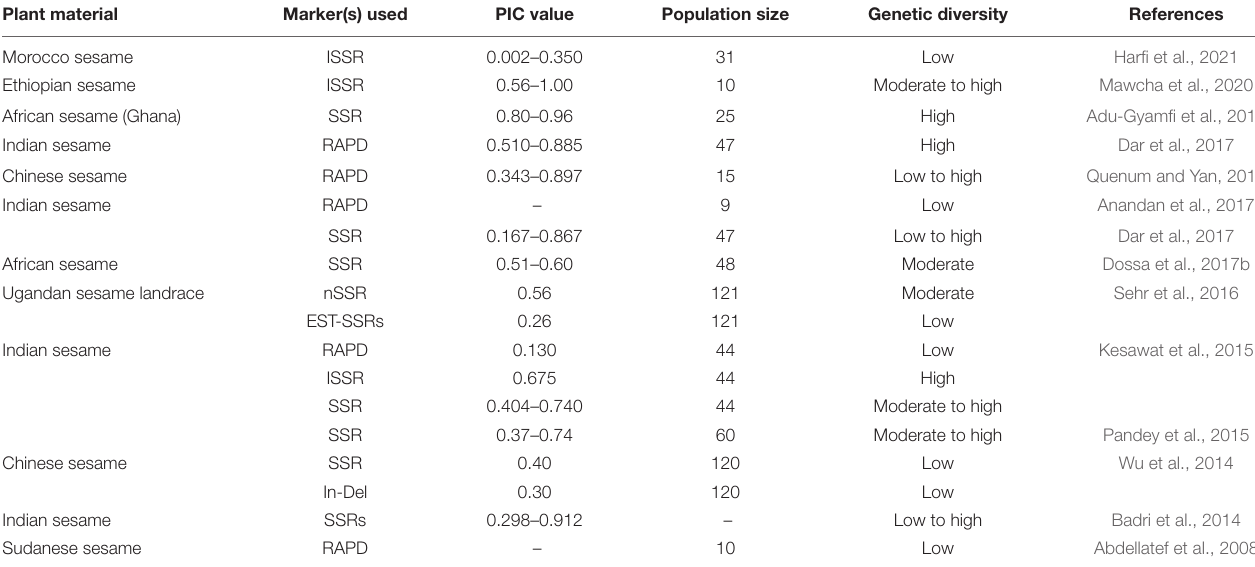
TABLE 2 | Use of molecular markers for genetic diversity assessment in sesame. Plant